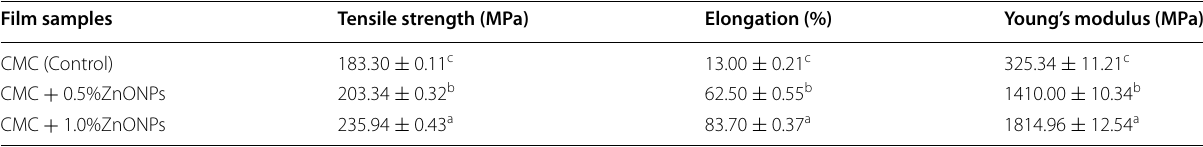
Calculated mean is for triplicate measurements from three independent experiments a–c Means with different superscripts in the same column are considered statistically different (LSD test, P